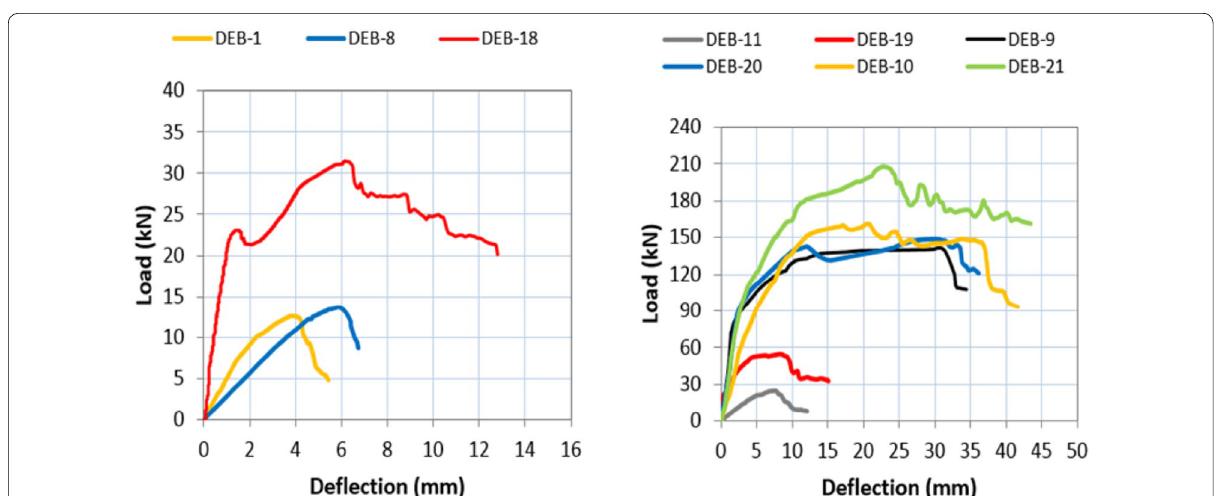
Fig. 22 Comparison of load–deflection relationship in the first and second group (For DEB-1,-8,-18,-11,-19,-9,-20,-10 and